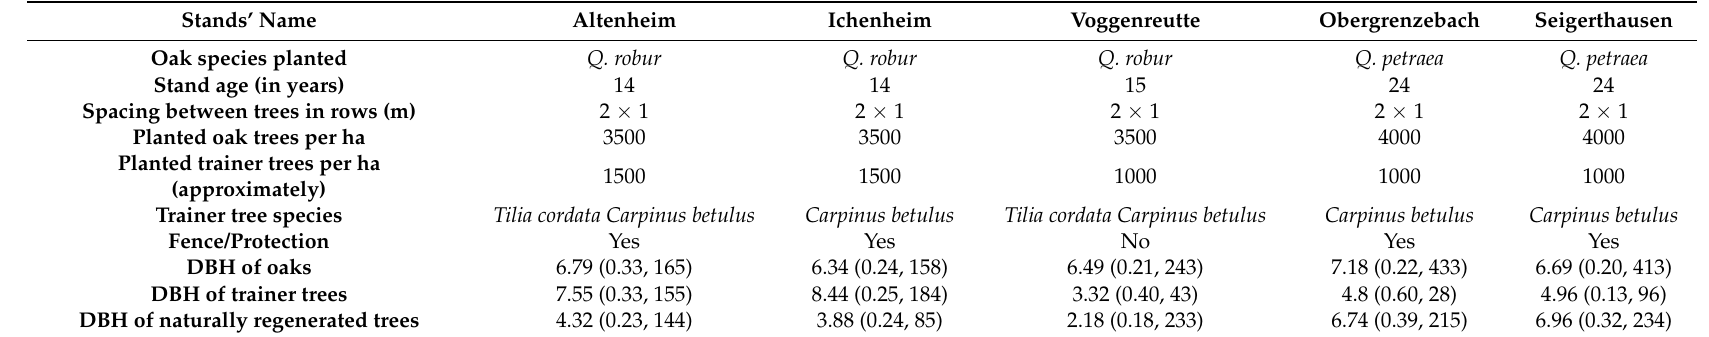
Table 3. Details of row planting designs and current mean DBH (in cm) of planted oaks, trainer and naturally regenerated trees in row planting stands. Standard error and number of trees inventoried are given within